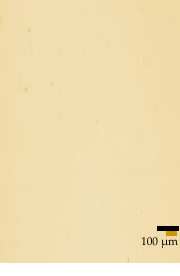
Figure 1. SEM micrographs of MC powder ( a ) × 1500 and ( b ) × 4000.